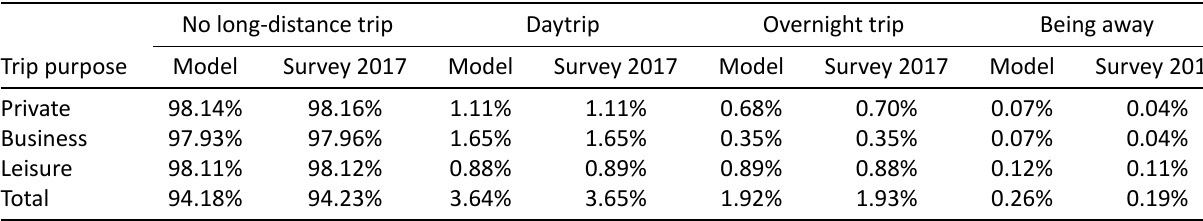
Table 2. Long‐distance trip generation results.